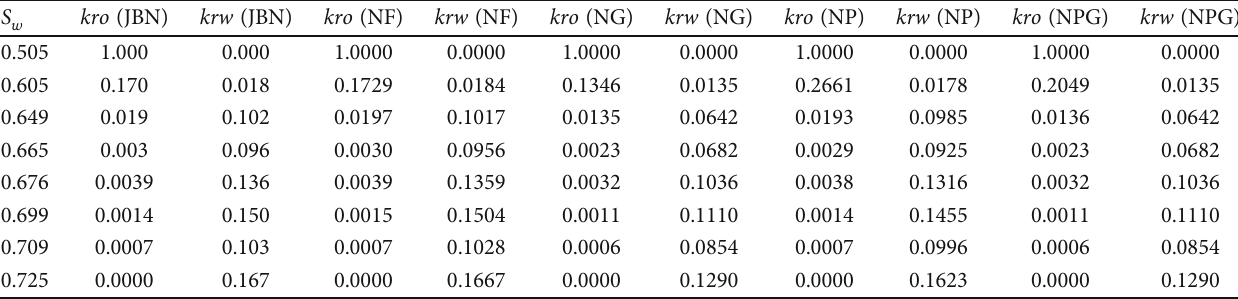
Table 5: Calculation results of oil – water relative permeability of core C116.